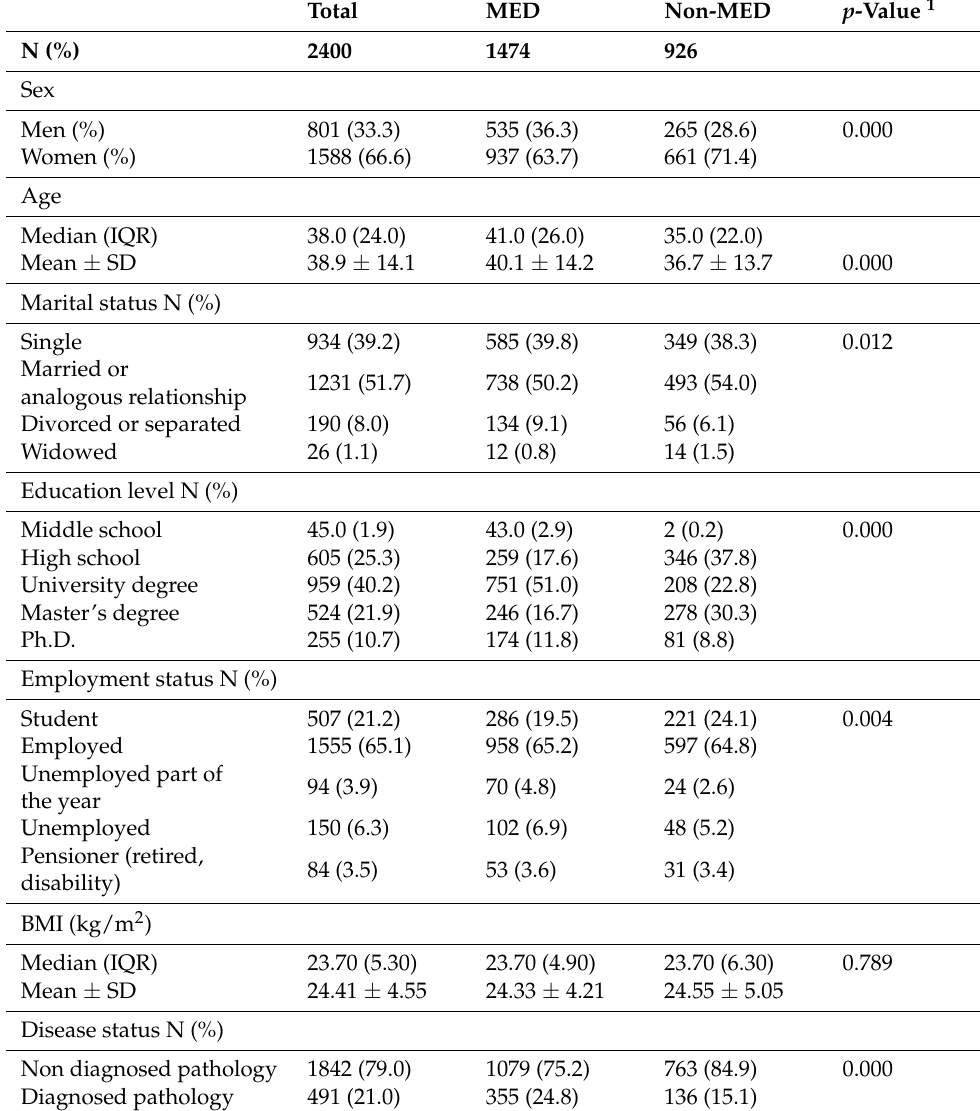
Table 1. Participants’ sociodemographic characteristics and health status related factors: total popula- tion, and MED and non-MED groups of countries. Total